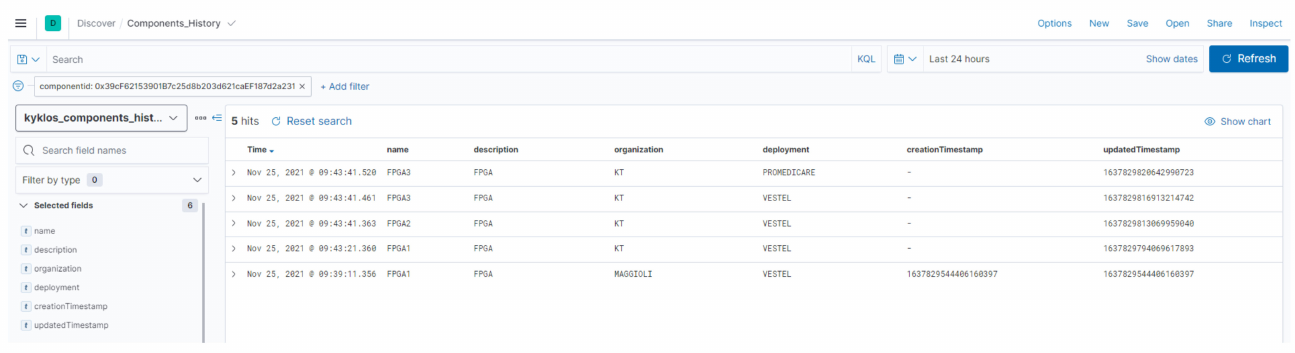
Figure 5. Example of a graphical monitor client (history report from KYKLOS 4.0